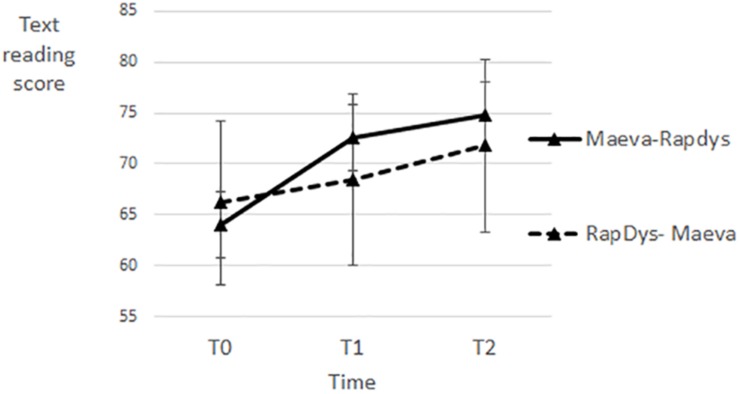
Text reading scores for each time period and each presentation order.